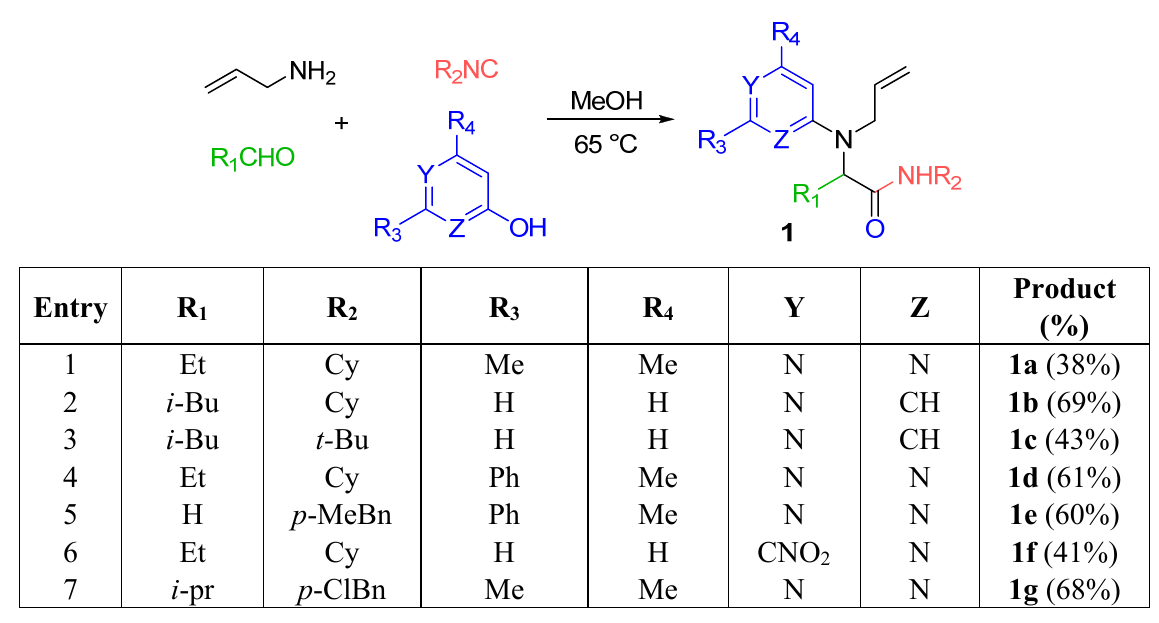
Table 1. Preparation of the radical